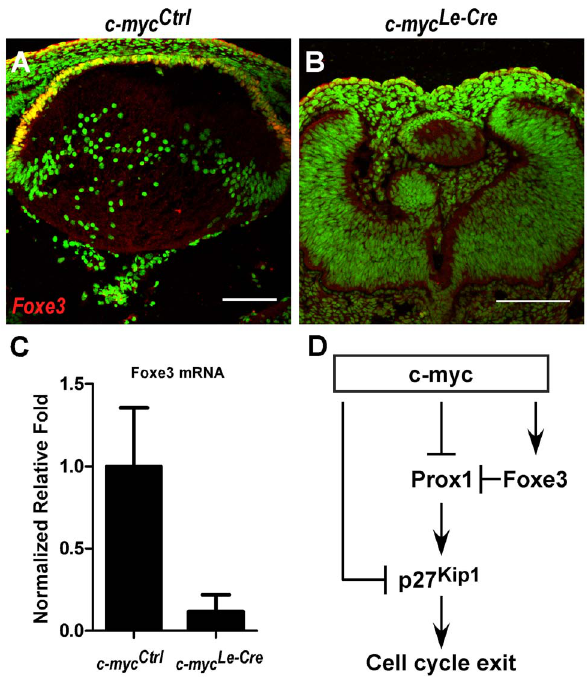
Figure 8. Misregulation of Foxe3 expression in c-myc-deficient lens. (A–B) Representative confocal pictures of an immunofluores- cence for Foxe3 performed in control ( c-myc Ctrl ) ( A ) and c-myc-deficient ( c-myc Le-Cre ) ( B ) lens sections at E13.5 followed by sytox green nuclear counterstaining. ( C ) Real-time RT-PCR analysis of Foxe3 mRNA expression in control ( c-myc Ctrl ) and c-myc-deficient ( c-myc Le-Cre ) lens at E17.5. Gapdh ( Gapd ) was used to normalize Foxe3 expression. A sharp decrease in Foxe3 mRNA and protein expression was detected after c-myc inactivation ( D ) Schematic illustration of the proposed roles of c-myc in developing mouse lens. The ectopic expression of Prox1 and p27 Kip1 proteins in lens epithelial cells of the c-myc Le-Cre mice suggests that the expression of these cell-cycle exit inducers may be regulated by c-myc in the embryonic lens. The expression of Foxe3, a known regulator of Prox1, was also misregulated in c-myc-deficient